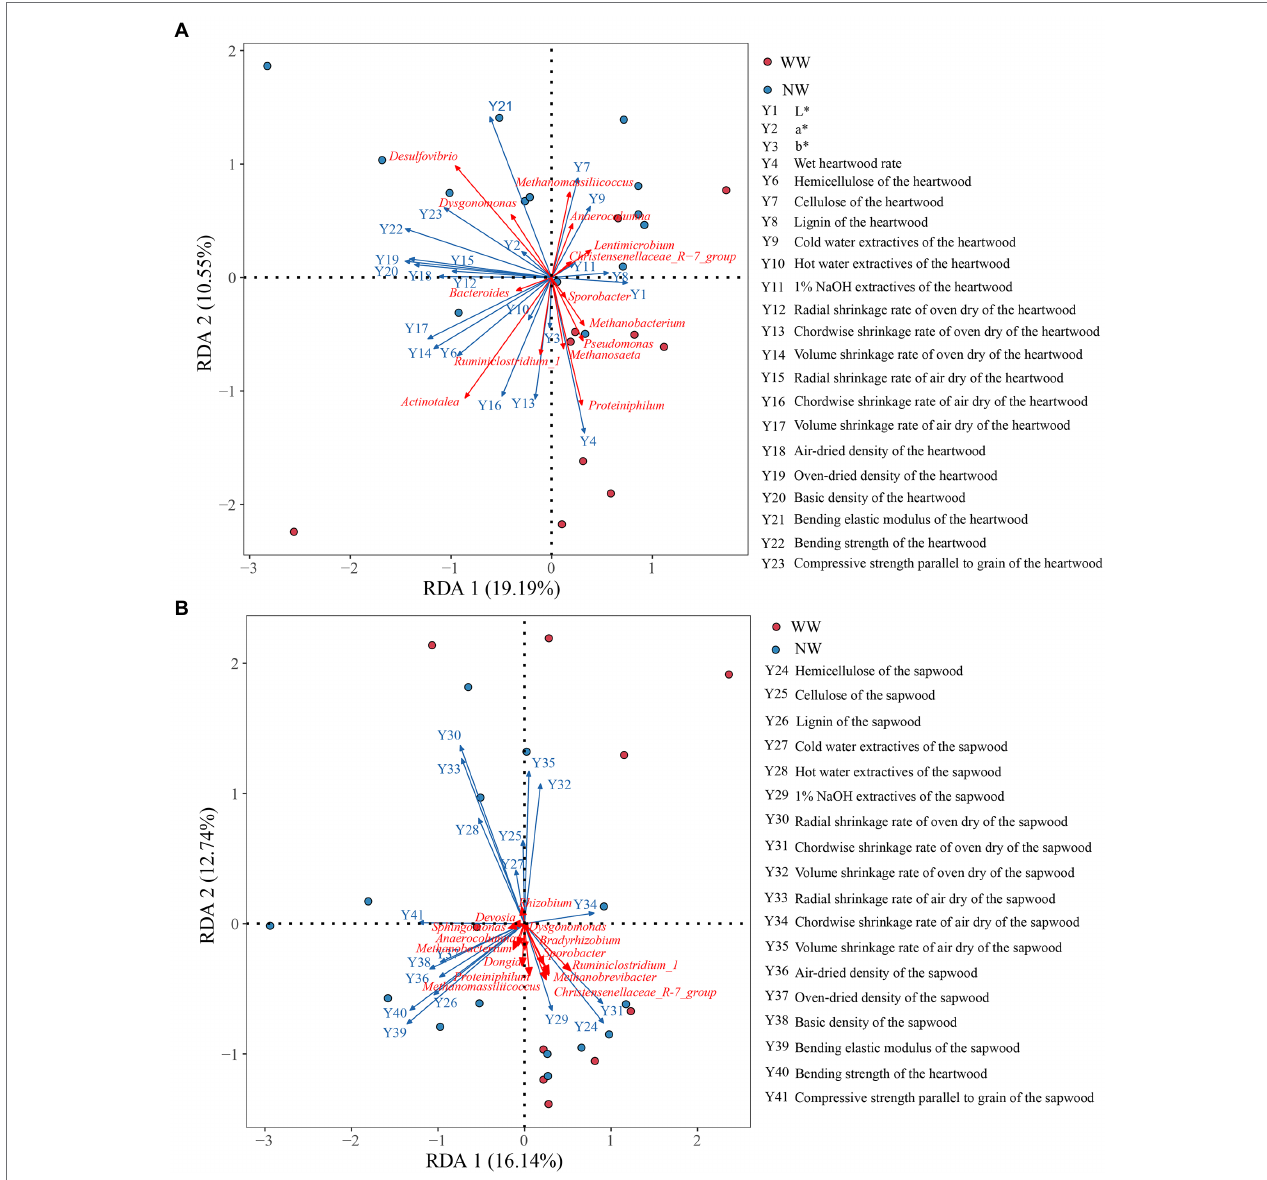
FIGURE 9 | db-RDA analysis of the endophytic bacteria and the chroma value, wet heartwood rate, and the wood properties. (A) The relationship between endophytic bacteria of the heartwood and wood variables of the heartwood; (B) The relationship between endophytic bacteria of the sapwood and wood variables of the sapwood. WW and NW represent diseased and healthy trees,